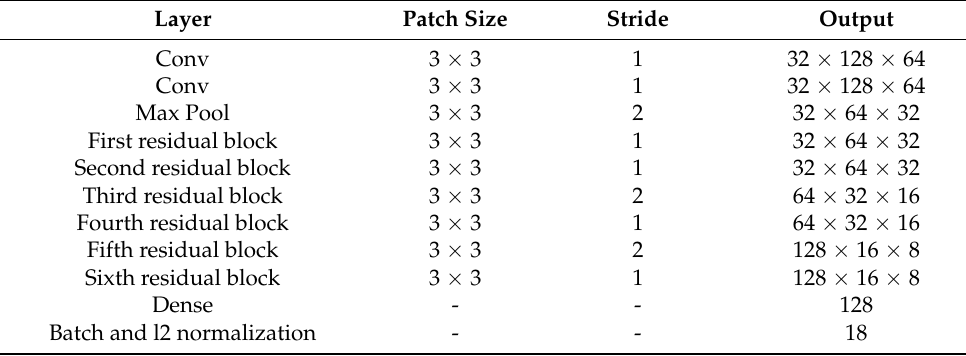
Table 1. CNN architecture of the deep feature extractor convolutional neural